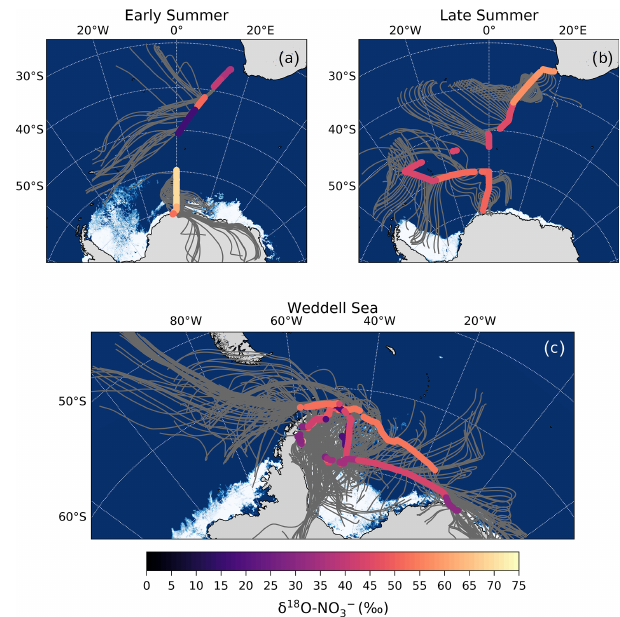
Figure 3. The 72h AMBTs (grey lines) computed for each hour of the voyage when the HV-AS was operational for more than 45min of the hour during early summer (a) , during late summer (b) and in the Weddell Sea (c) . The colour bar represents the weighted average δ 18 O of coarse-mode ( > 1µm) atmospheric nitrate ( δ 18 O–NO − Individual AMBTs for each aerosol sample from the Weddell Sea are shown in Fig. S1. The white area represents the location of the sea ice (see Fig. 2